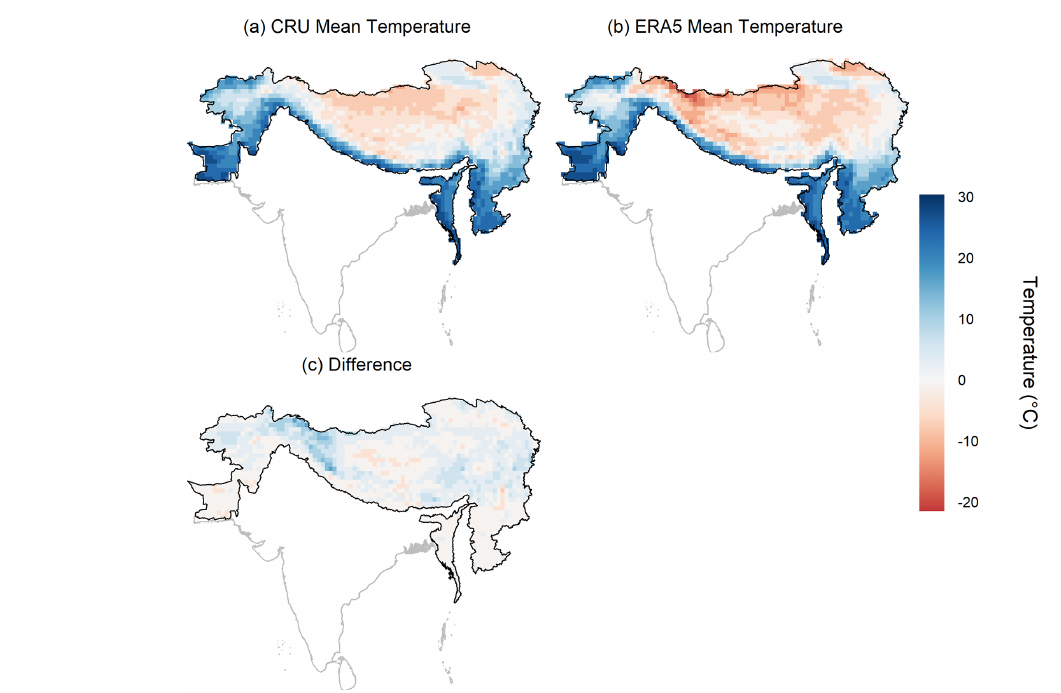
Figure 9. Comparison of temperature (a) average CRU (1979–1990), (b) ERA5 data (1979–1990) and (c) the difference between the ERA5 and CRU datasets in degrees Celsius.